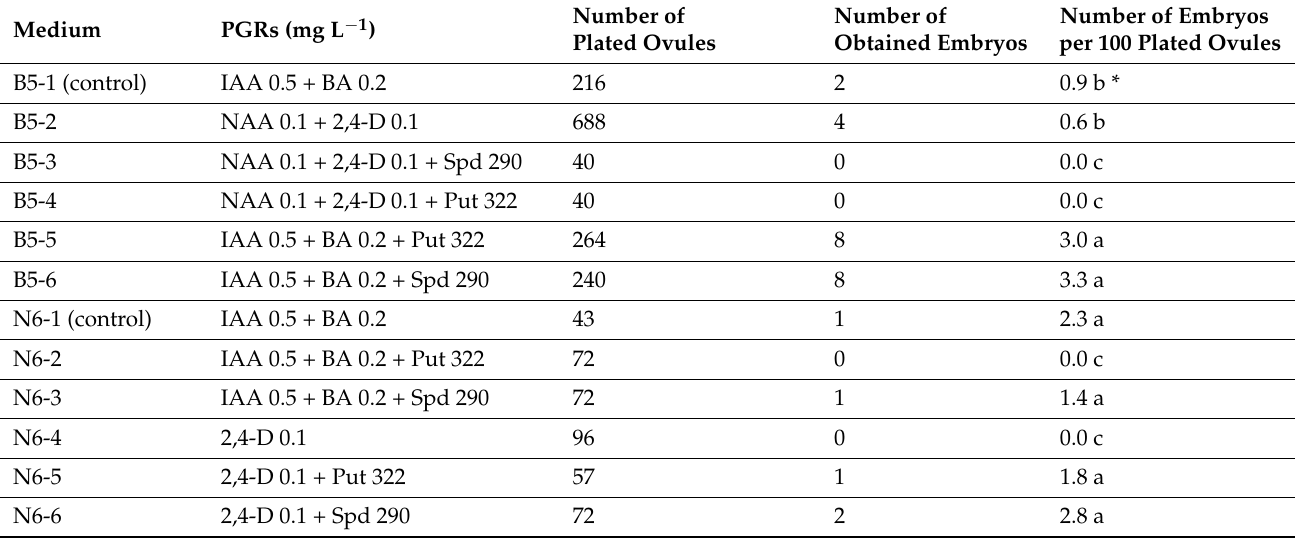
Table 2. Influence of the composition of the B5 induction medium on the effectiveness of gynogenesis in red beet “Czerwona Kula”.